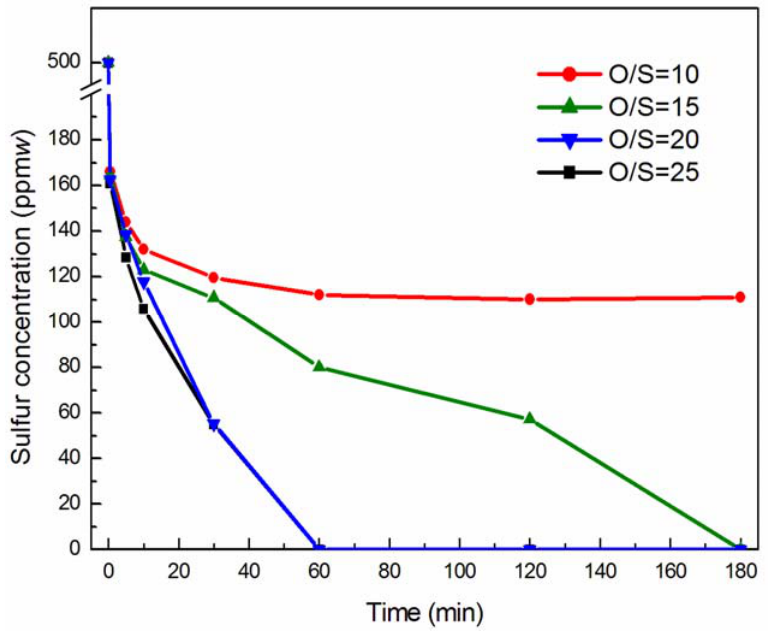
Figure 4. The effect of different O/S molar ratio on ODS of simulated oil. Experimental conditions: pre-reaction time 10 min; temperature 60 °C; the amount of catalyst used was 1% the mass of n -octane; and DBT (S: 500 ppm( w ) in n